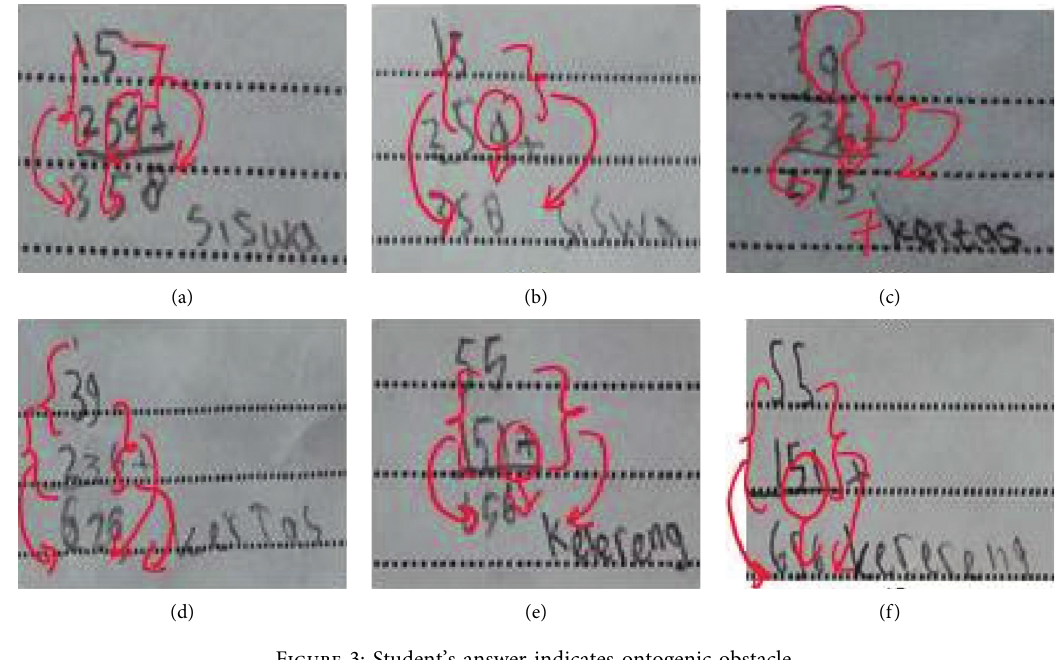
Figure 3: Student’s answer indicates ontogenic obstacle.